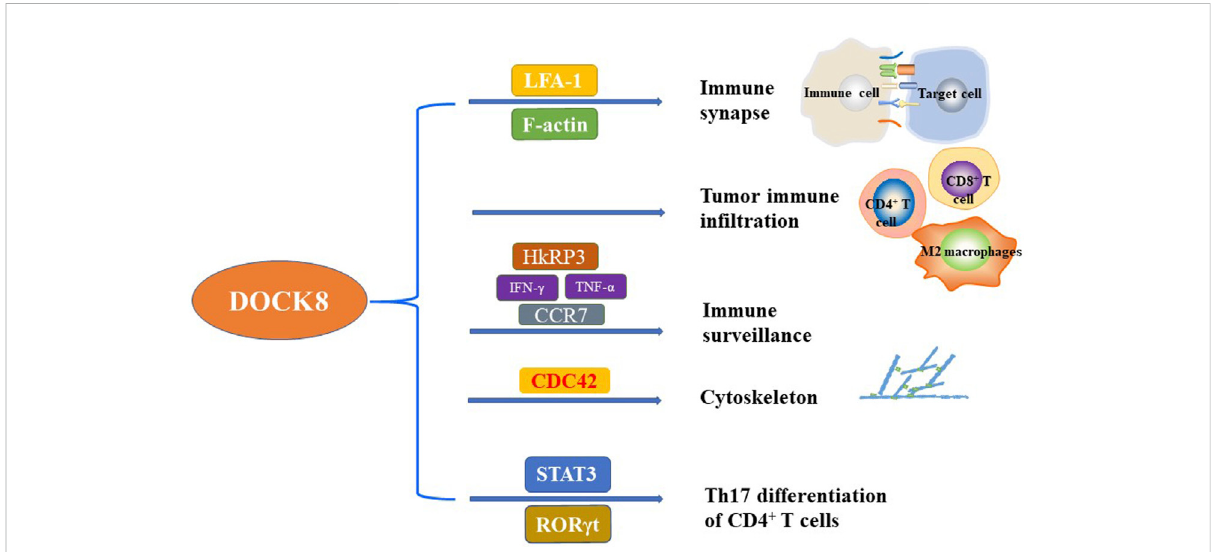
FIGURE 1 ThecriticalfunctionofDOCK8ontheregulationofimmunity.DOCK8playsimportantroleinregulatingtheimmunityandmaintainingthebasic function of multiple immune cells. The main function of DOCK8 related to immunity included but not limited to the regulation of immune synapse, tumor immune in fi ltration, immune surveillance, cytoskeleton, and Th17 differentiation of CD4 + T